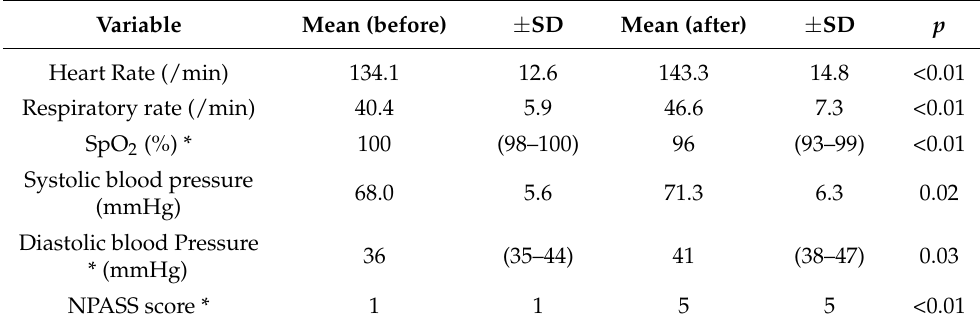
Table 2. The patients’ vital signs and pain scores before and after ultrasonographic application (not normally distributed values are given with the median, and 25th and 75th percentiles, and marked with *).